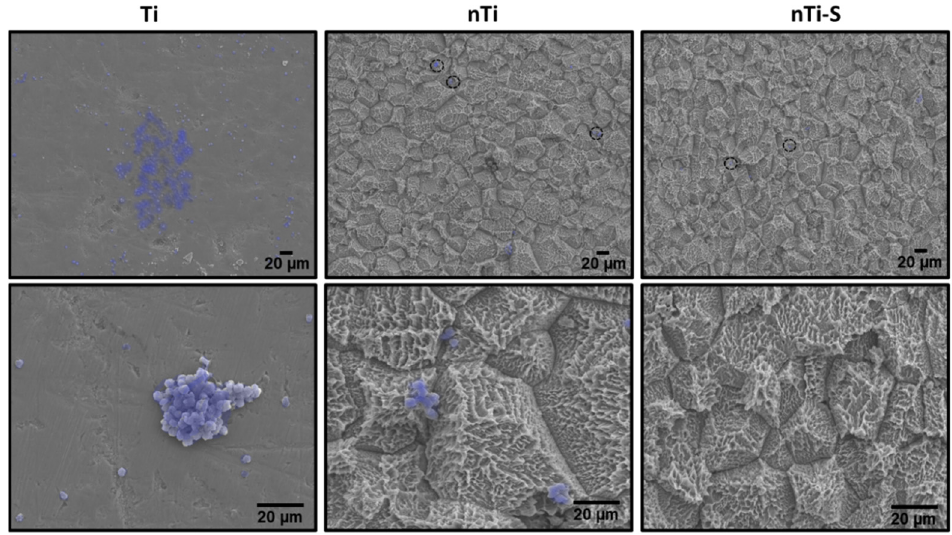
Figure 4. Representative SEM images of adhered platelets and WBCs (purple—Photoshop used for better visibility) on different surfaces. Images were taken at 500× and 2000× magnification. (n min = 9.)